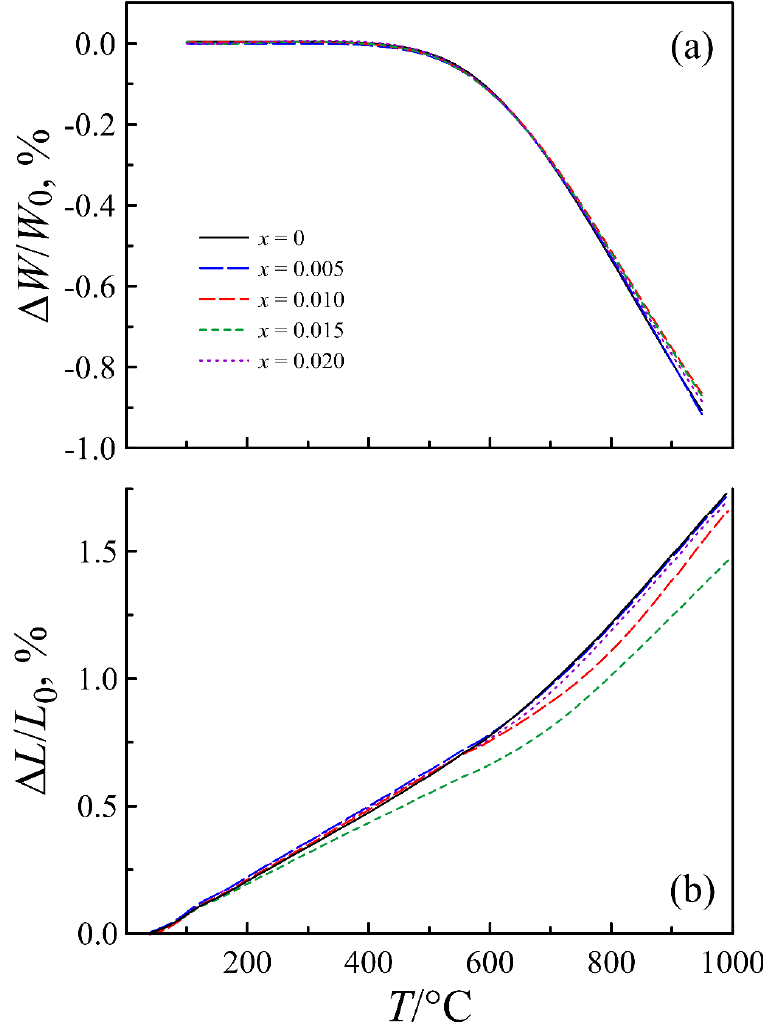
Figure 3. Relative weight change ( a ) and relative elongation ( b ) of a ceramic sample of La 0.5 − x Sr 0.5 FeO 3 − δ as functions of temperature.